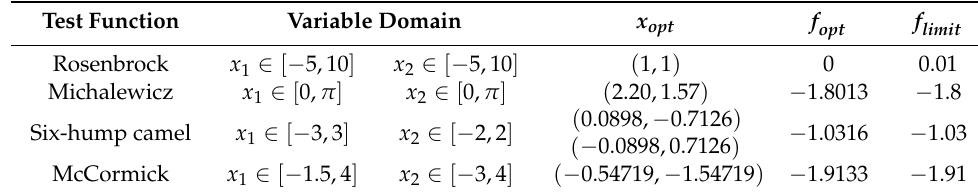
Table 4. Mathematical optimization test functions.